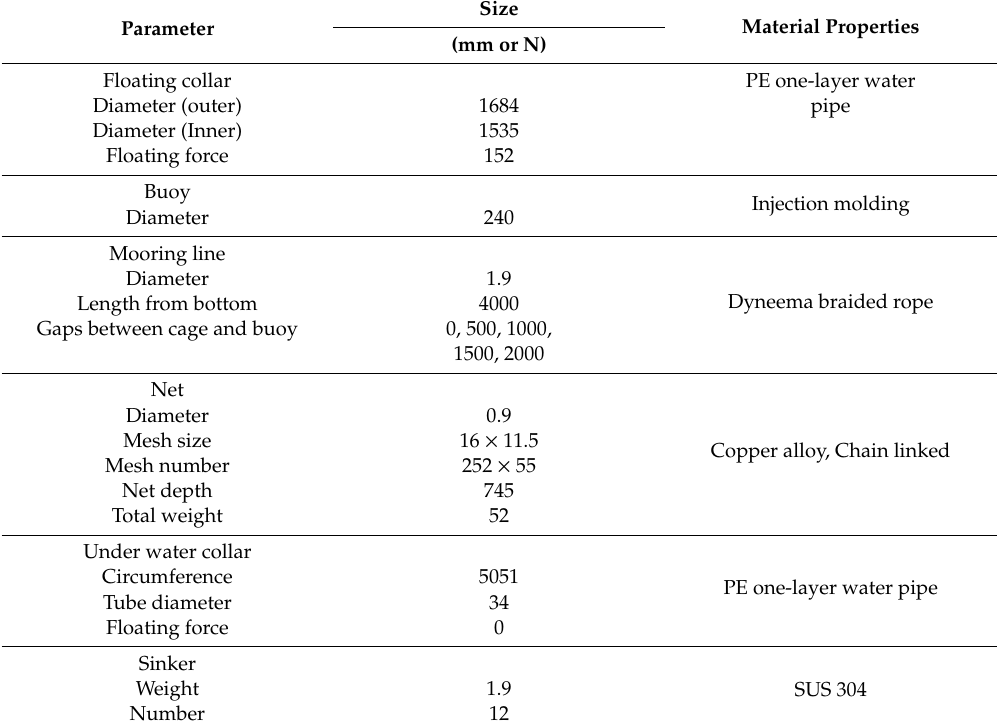
Figure 1. Schematic diagram of a fish cage (1 / 15 scale) for numerical modeling (Cha and Lee [12]). Table 1. Specifications of the model cage for numerical modeling (cage model used in Cha and Lee [12]’s experiment).